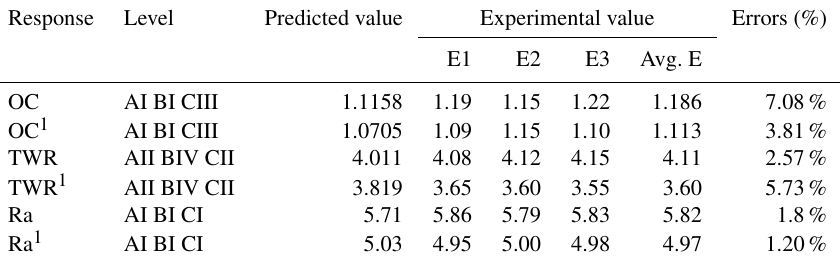
Table 10. Conformation table.